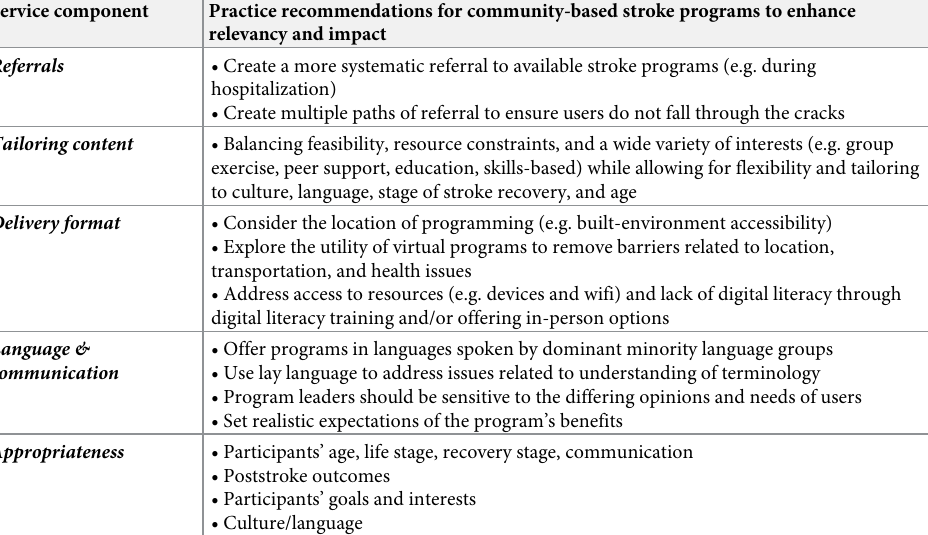
Table 5. Practice recommendations for community stroke services to enhance access and